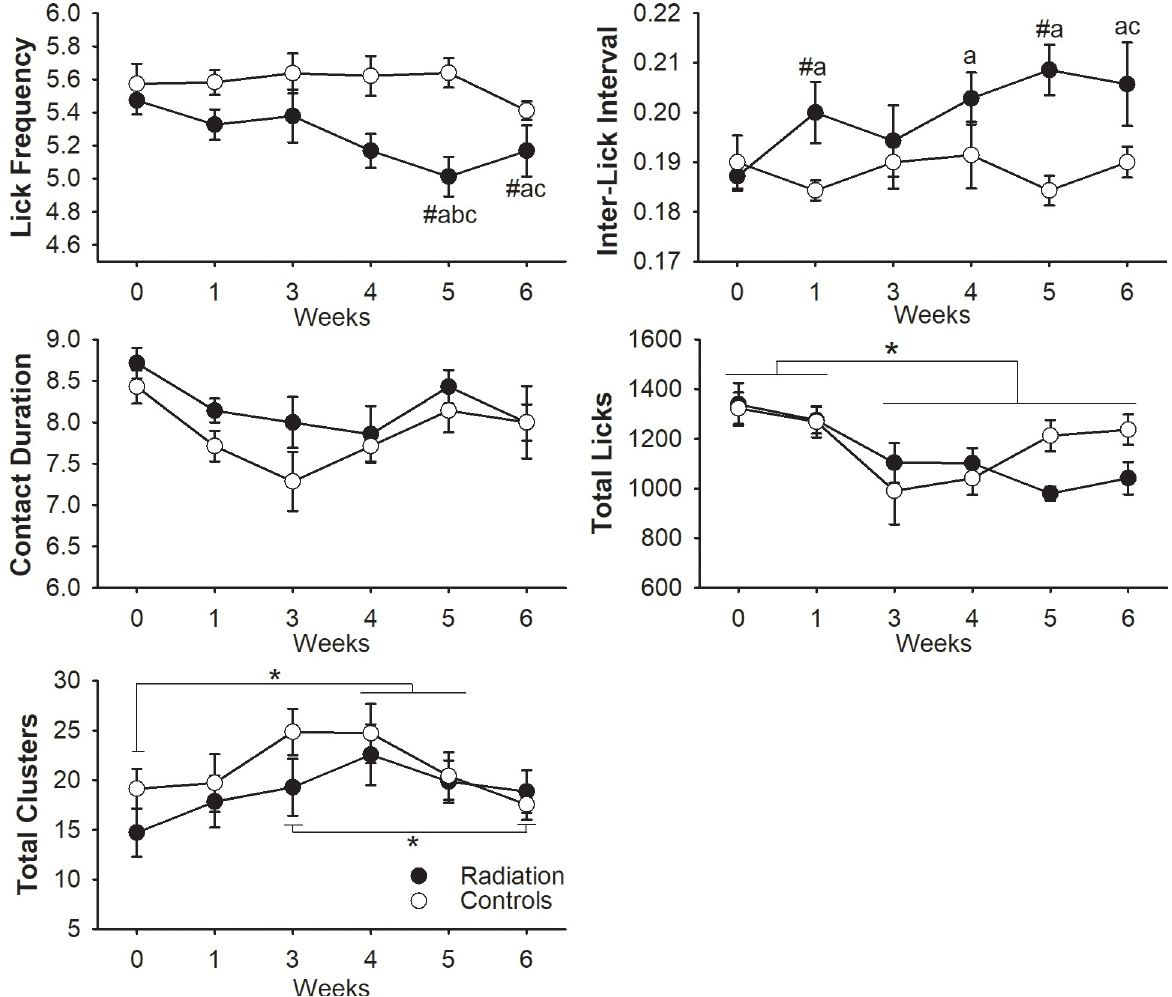
Fig 3. Alterations in the licking microstructure of rats treated with radiation. Licking was analyzed at baseline (0 [a]), during radiation (1- [b], 3- [c], and 4- [d] weeks), and after completion of radiation (black) or sham (white) treatment (5- [e] and 6- [f] weeks). Results demonstrate the mean and standard deviations for lick frequency (Hz), interlick interval (seconds), contact duration (seconds), and the total number of licks and clusters. Significant differences (p < 0.05) between groups are indicated by # and differences across time are designated by letters. Significant main effect for time was indicated by